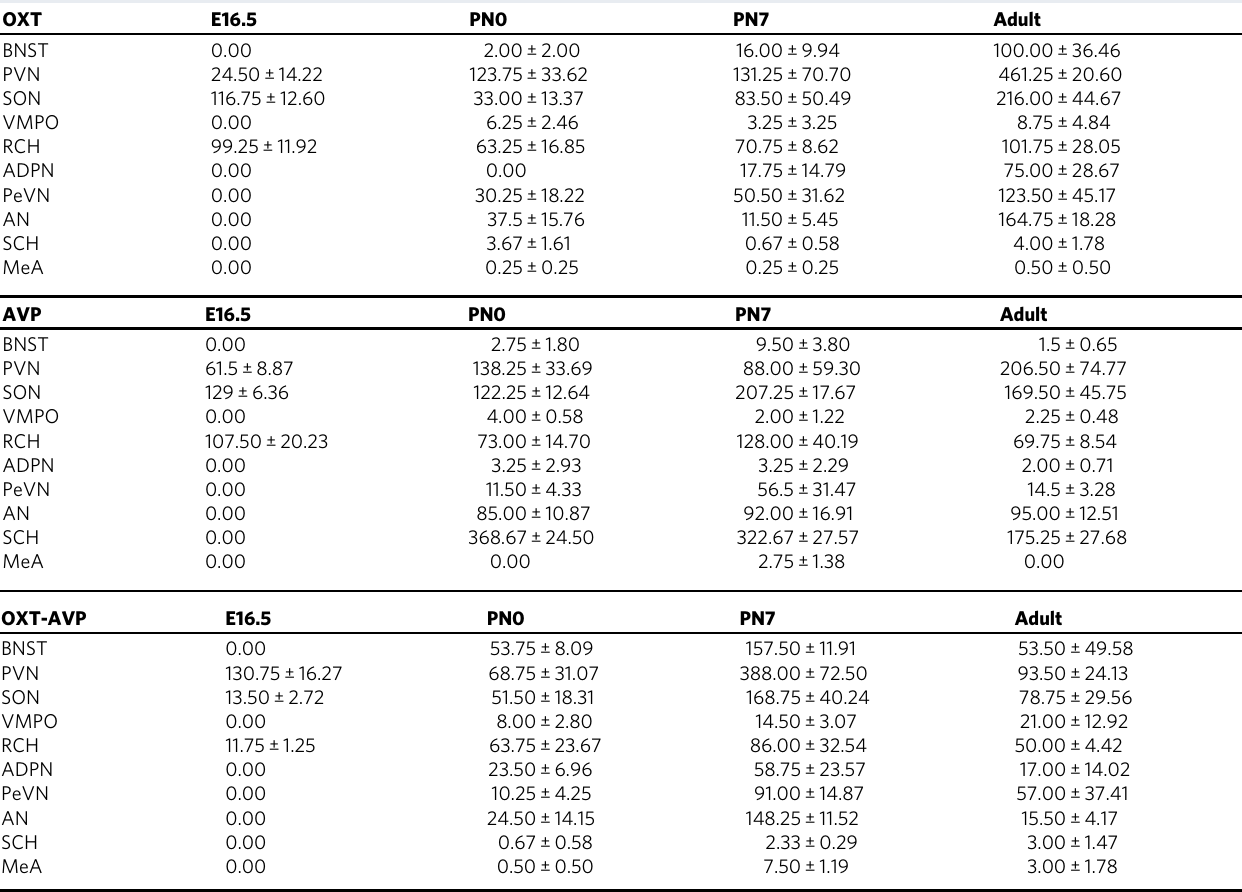
Table 1 Total number of OXT, AVP, and OXT + AVP neurons in the hypothalamus nuclei during development.